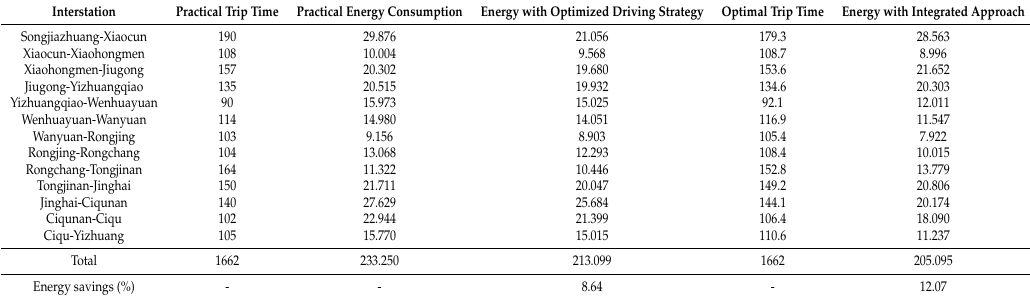
Table 6. Comparison of energy consumption between the energy-efficient driving strategy and integrated timetable optimization; the unit of the energy consumption is kW ·